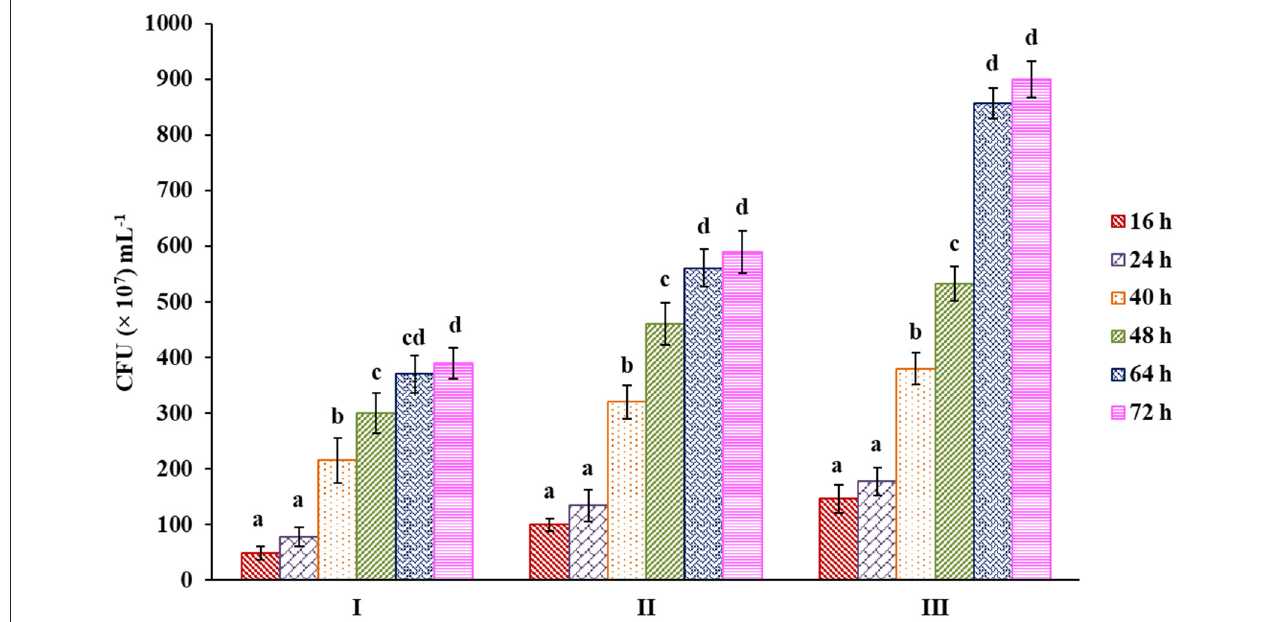
FIGURE 6 | Bacterial count from samples of culture media with control (I), sugar (II) and pectin (III) as carbon source. Bars sharing the same letter within a treatment are not significantly different ( P < 0.05). Error bars represent standard